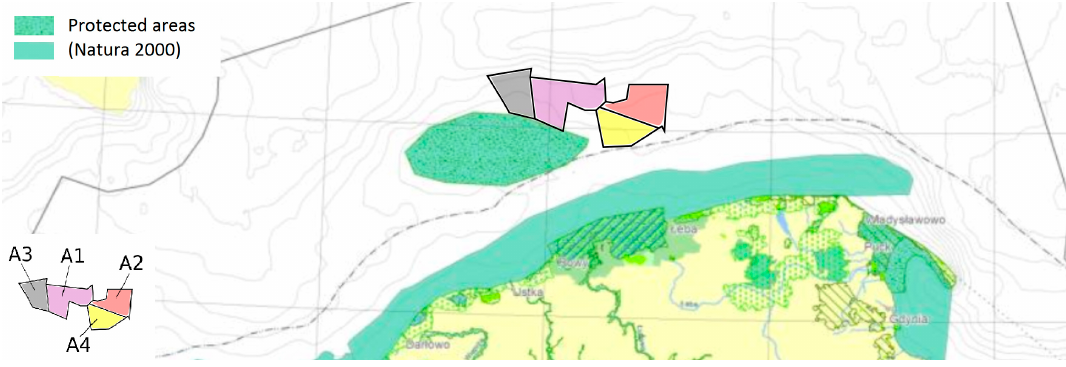
Figure 8. The decision variants against the background of Natura 2000 protected areas.